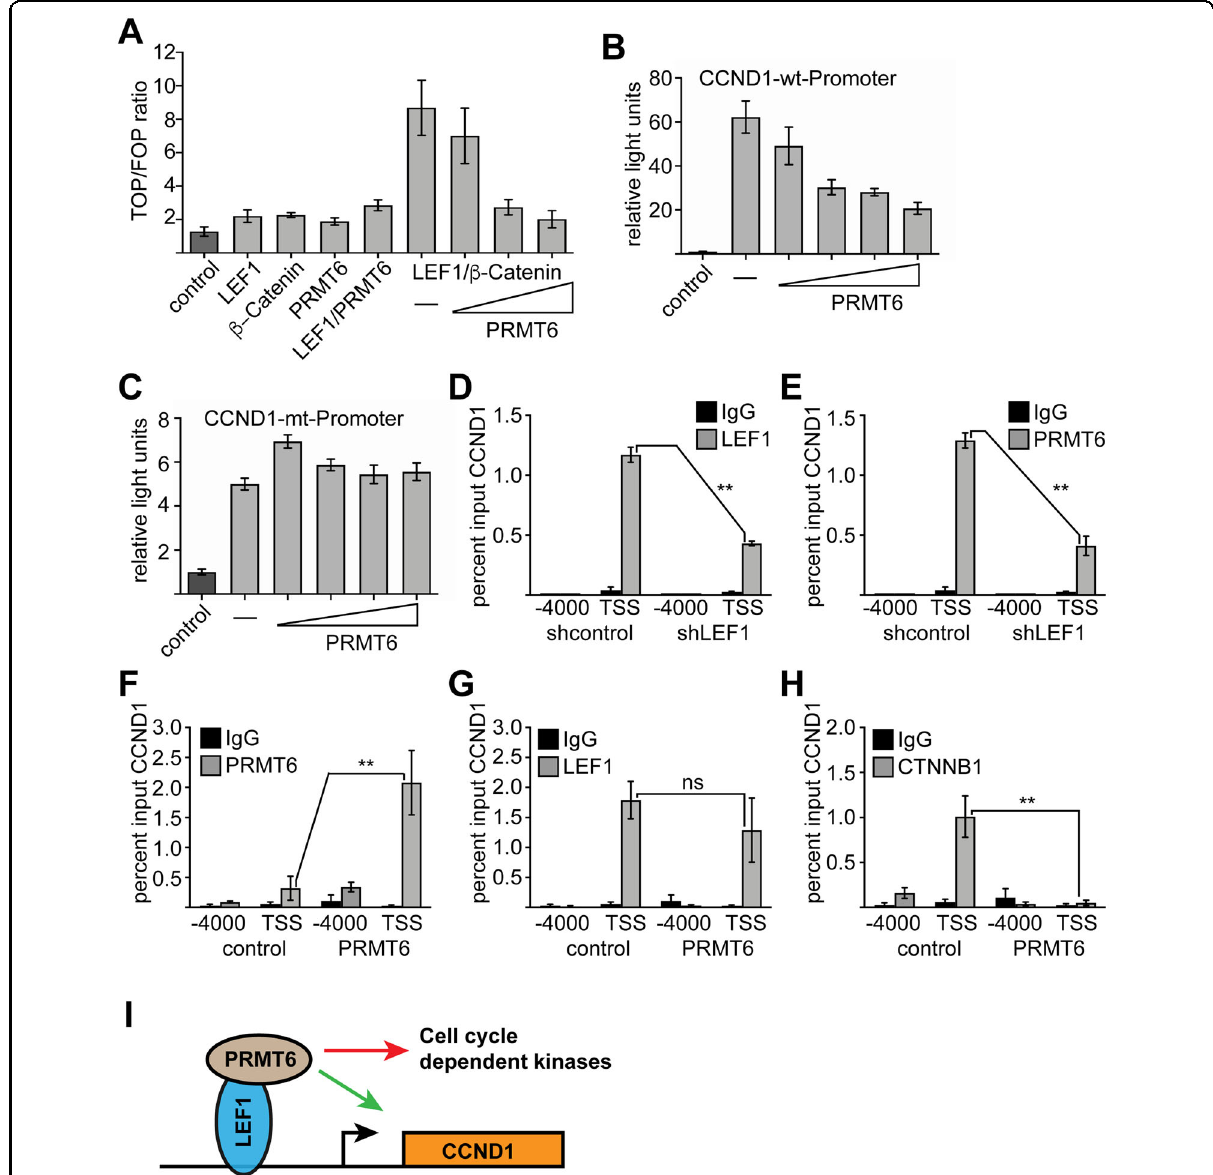
Fig. 6 Interdependence of LEF1 and PRMT6 on CCND1 . A PRMT6 TOP-Flash assay. The M50 Super 8x TOP-Flash 11 was co-transfected with LEF1, PRMT6 and N89-(constantly active) β -Catenin 12 into HEK293T cells. The negative control M51 Super 8× FOP-Flash was used for normalization. Co- transfection of LEF1 and N89-ß-Catenin leads to the highest TOP/FOP ratio. Increasing PRMT6 amount decreased the activating effect of β -Catenin . B , C CCND1 luciferase assay. The bars represent the mean with standard deviation of two independent experiments, each measured in technical duplicates. D , E ChIP assay was performed seven days upon knockdown of LEF1 in K562 cells. Binding of LEF1 and PRMT6 to the CCND1 promoter was reduced upon LEF1 knockdown. F ChIP assay upon over expression of PRMT6 in K562 cells. PRMT6 occupancy at the CCND1 promoter (transcription start site; TSS) was increased upon over expression of PRMT6. PCR with a primer localized at − 4000 served as negative control. G ChIP assay with a LEF1 antibody upon over expression of PRMT6. LEF1 binding to the CCND1 promoter was not altered signi fi cantly. H ChIP assay revealed that binding of CTNNB1 ( β -Catenin) was reduced upon over expression of PRMT6. Error bars represent the standard deviation from the mean. The P - values were calculated using Student ’ s t -test from at least three independent measurements. ** P < 0.01. I Schematic representation of LEF1/PRMT6 activity on cell cycle genes.